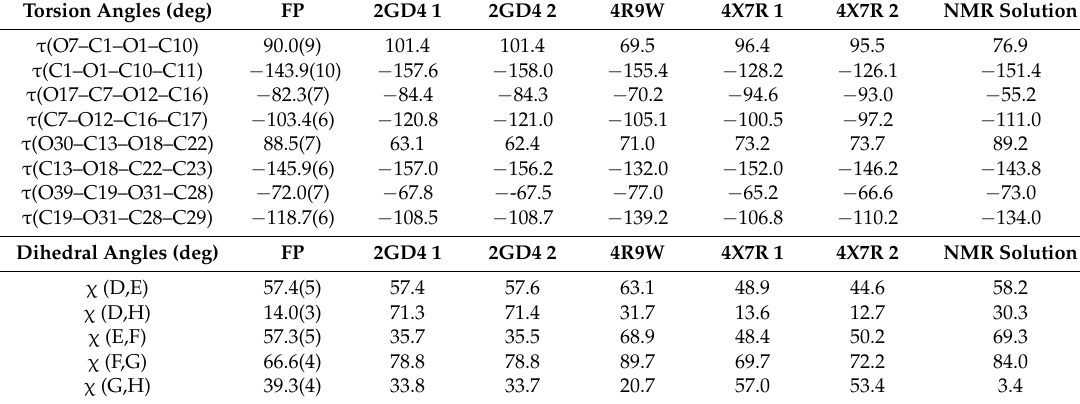
Table 2. Description of the overall conformation of the pentasaccharide in terms of torsion angles (deg.) of the C–O backbone in the glycosidic links (see also Figure 5 where these backbones are highlighted) and dihedral angles (deg.) between least-squares planes fitted through the ring atoms. Atom and ring labels are given in Figure 5; s.u.’s are included in parentheses. For comparison, the values for various other structures are included in the Table, see the legend of Figure 1 for details of the abbreviations used